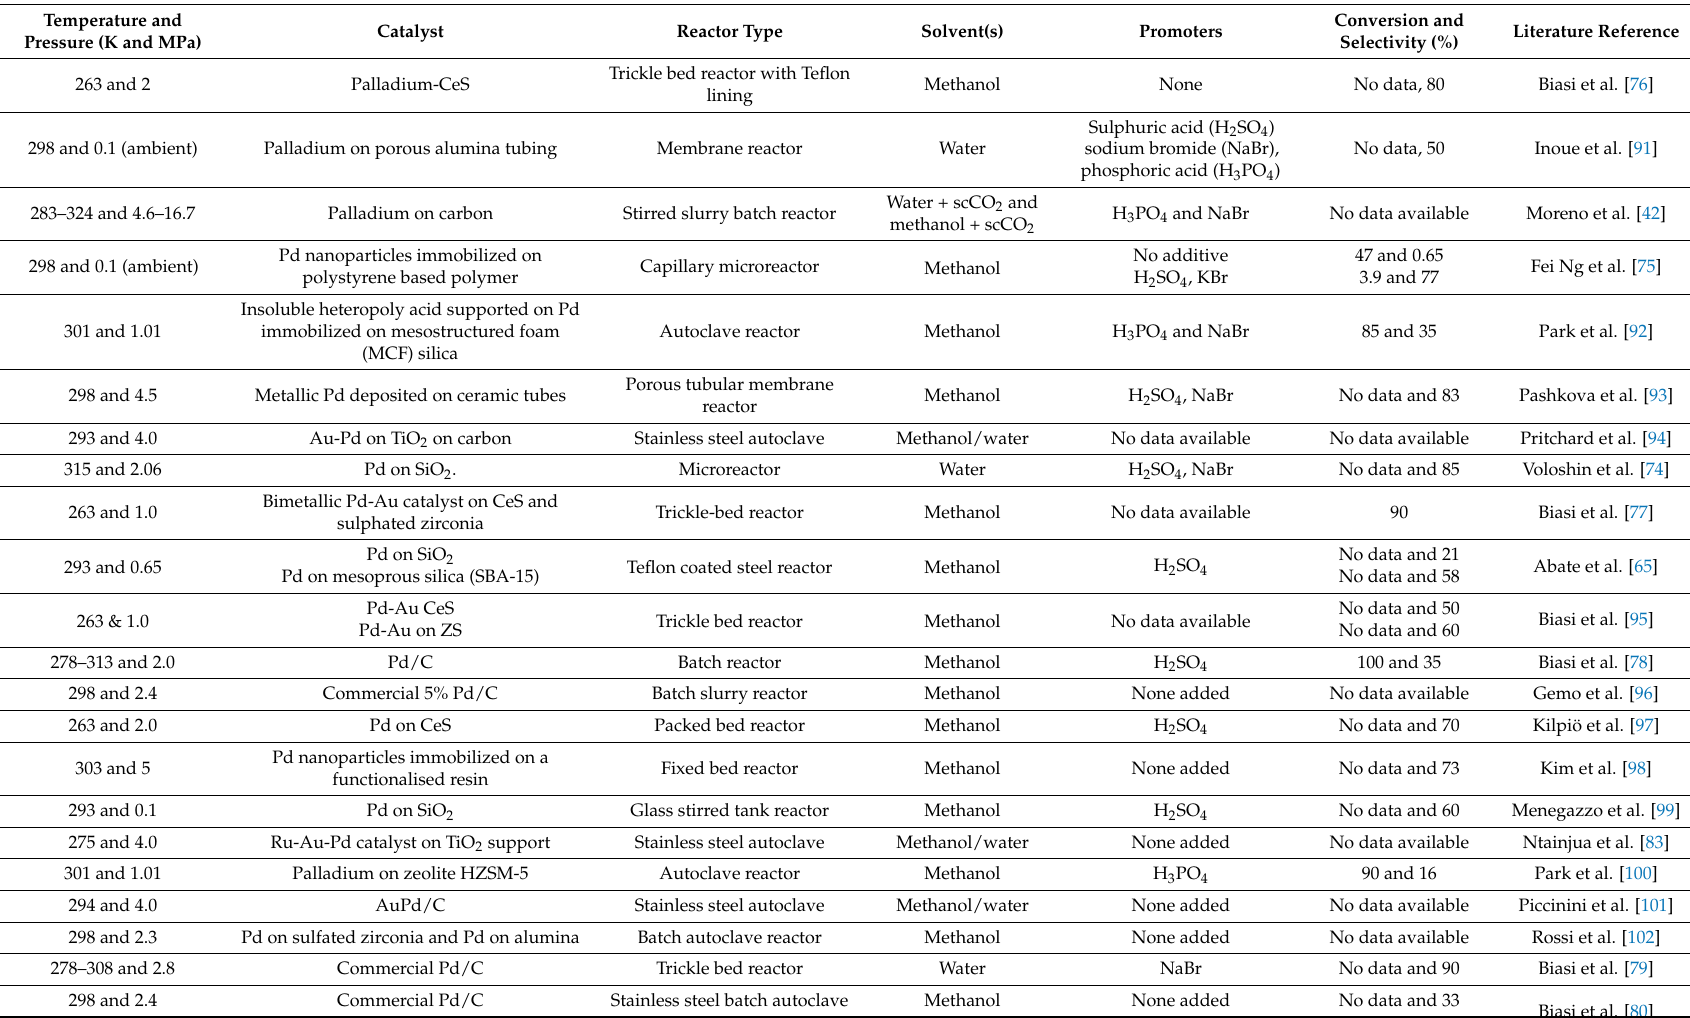
Table 4. List of operating conditions in literary works involving the direct synthesis of H 2 O 2 between 2010 and